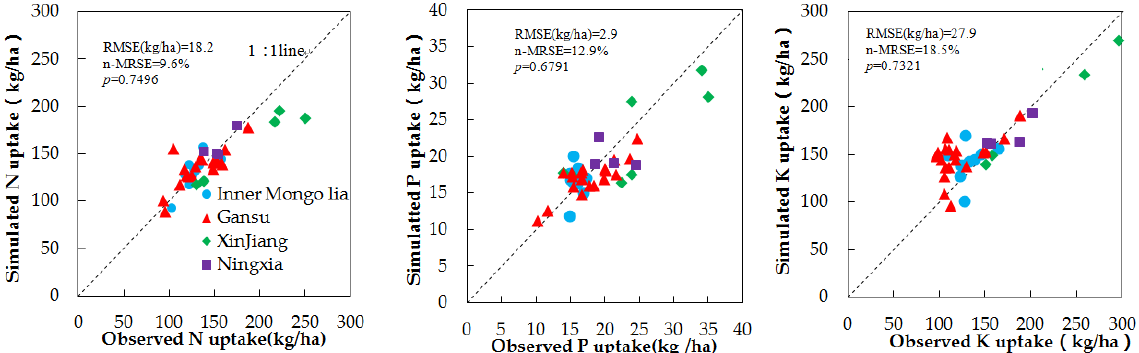
Figure 3. Nutrient requirements of N, P and K in total above-ground parts and fruit and removal ratio at different target yields simulated by the QUEFTS model for melon in China.